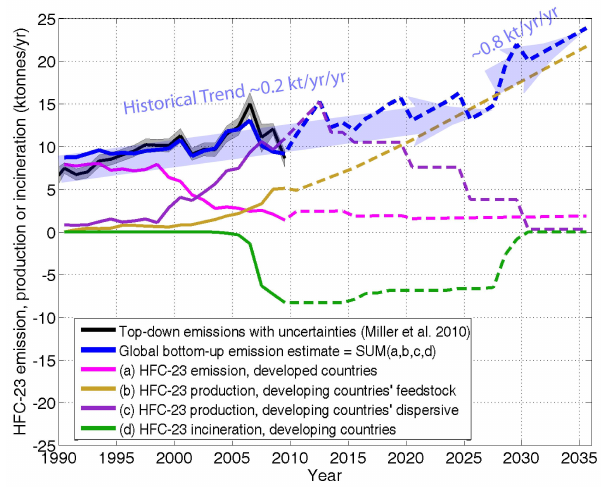
Fig. 1. Bottom-up HFC-23 emissions for developed countries (solid line a) (UNFCCC, 2010), and HFC-23 production and incinera- tion for developing countries (solid lines b–d) (Miller et al., 2010), shown along with the bottom-up global HFC-23 emissions, which are the annual sums of each of these components. The bottom-up emissions, production and incineration are projected (dotted lines) to 2035 based on the “Reference Case” (RC) assumptions. The RC scenario suggests that the historical trend in emission growth of ∼ 0.2ktonnesyr − 2 continues over much of the coming two decades. CDM project accreditation is scheduled to end by 2030, after which global emission growth quadruples to ∼ 0.8ktonnesyr − 2 and is controlled indefinitely by the unrestricted production of HCFC-22 for feedstock use. Note that this increase occurs despite the com- plete phase out of HCFC-22 for dispersive uses by 2030. The top- down global emission estimates of Miller et al. (2010) (solid black line with uncertainties in gray) are shown as emission verification of the global bottom-up